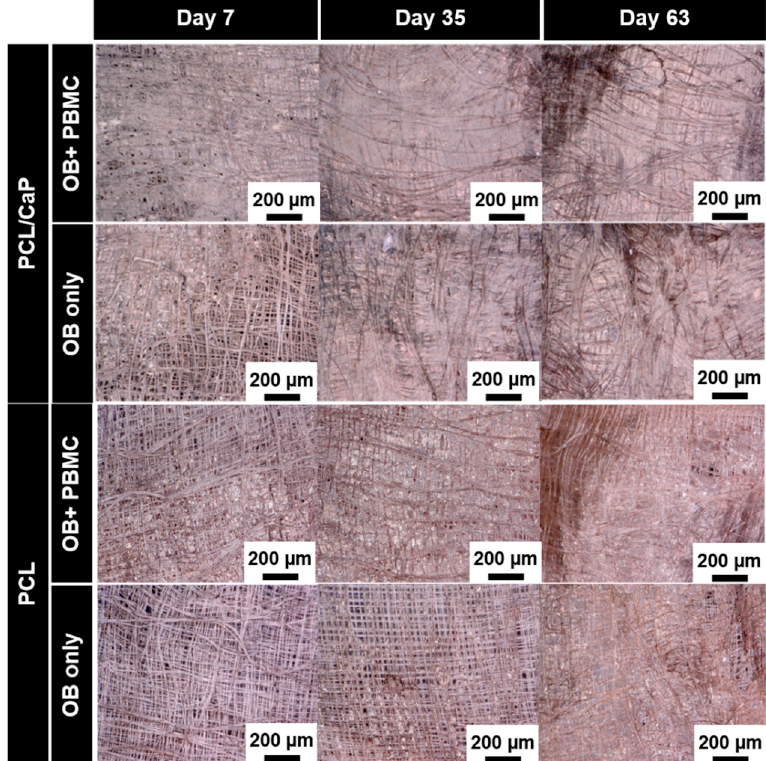
Figure 3. Digital microscopy images (100 × magnification) of osteoblast-peripheral mononuclear cell co-cultures (OB+PBMC) and osteoblast monocultures (OB only) on polycaprolactone (PCL) scaffolds with or without calcium phosphate surface coating stained with von Kossa at different time points.